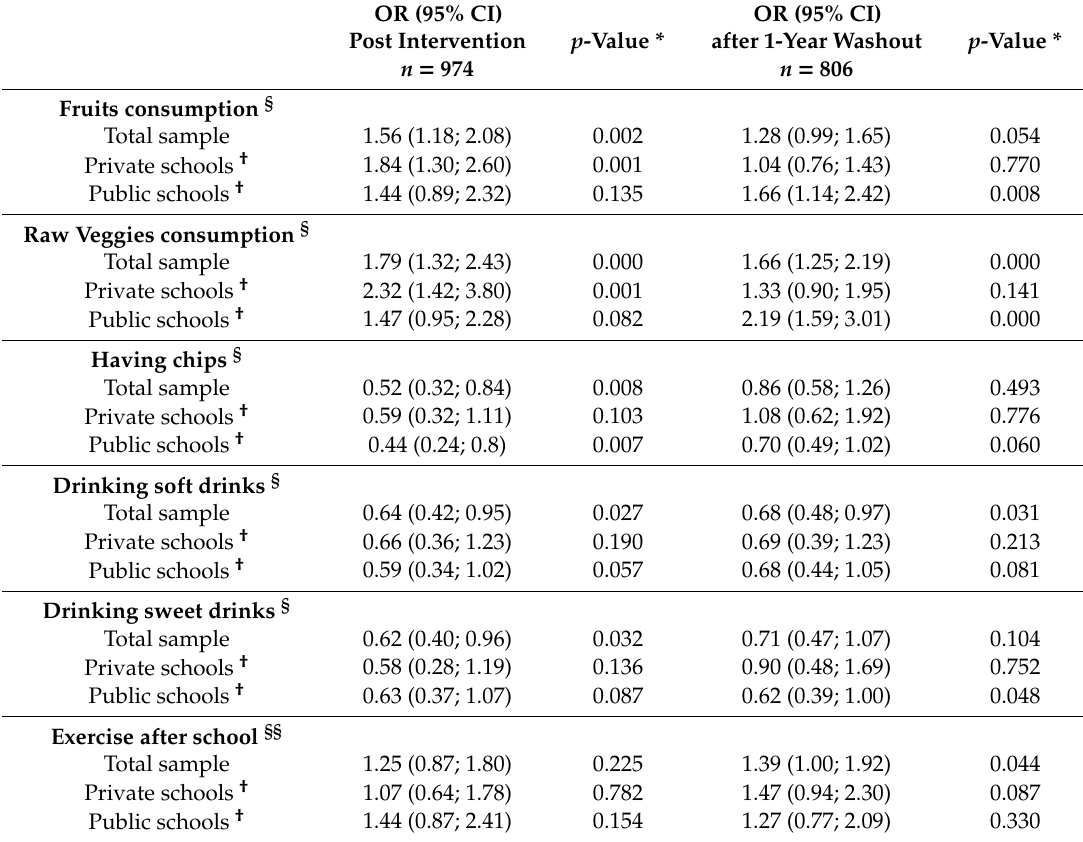
Table 4. Odds ratio of dietary habits change in response to the nutrition intervention among